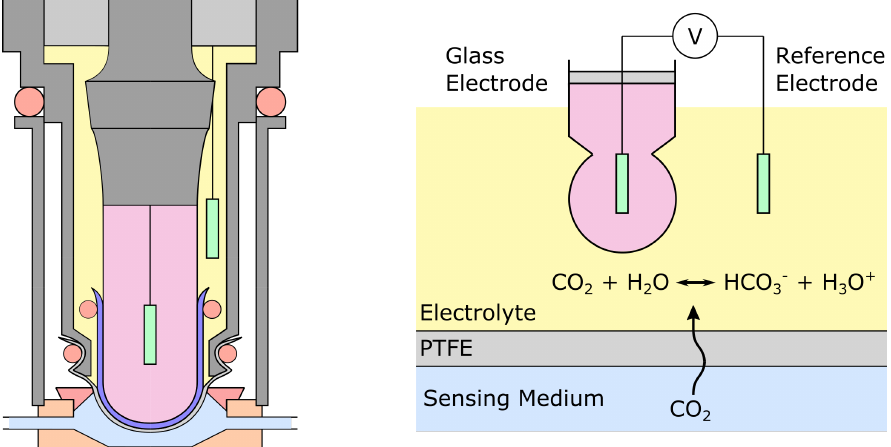
Figure 5. ( Left ) the Severinghaus electrode, an improvement of the Stow electrode, as first described in the 1958 publication [67]. The colour of the different elements matches that of the simplified schematic on the right. ( Right ) outline schematic of the Severinghaus electrode. CO 2 diffuses through a PTFE membrane into an electrolyte, causing a change in the pH of the latter. Such a change is then recorded by the mean of a pH-meter that consists of a glass electrode and a reference